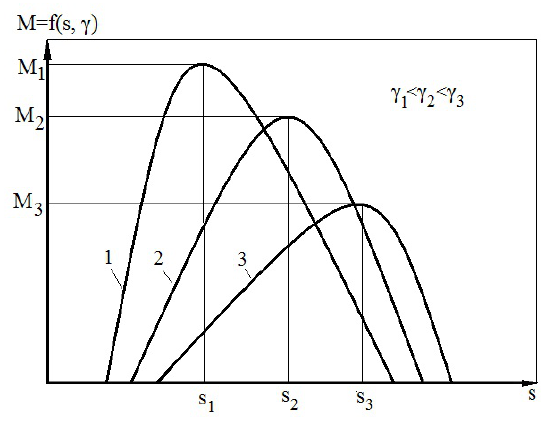
Fig. 8. The spectra of the VA signal 12 seconds before the break (Spectrum 1) and just before the break (Spectrum 2). In the right corner, the examples of VA signal recordings in 2 and 16 kHz octaves are shown For such type change in the